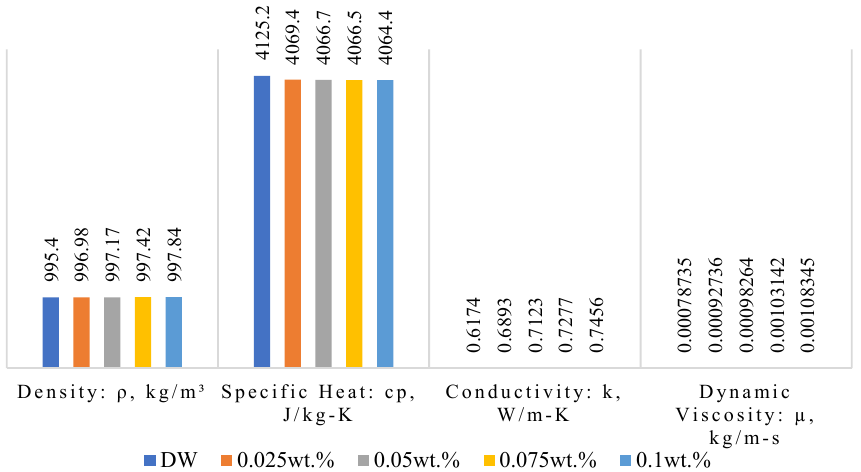
Figure 7. Thermo-physical properties of base fluid and nanofluids with different mass fractions at 30 °C.